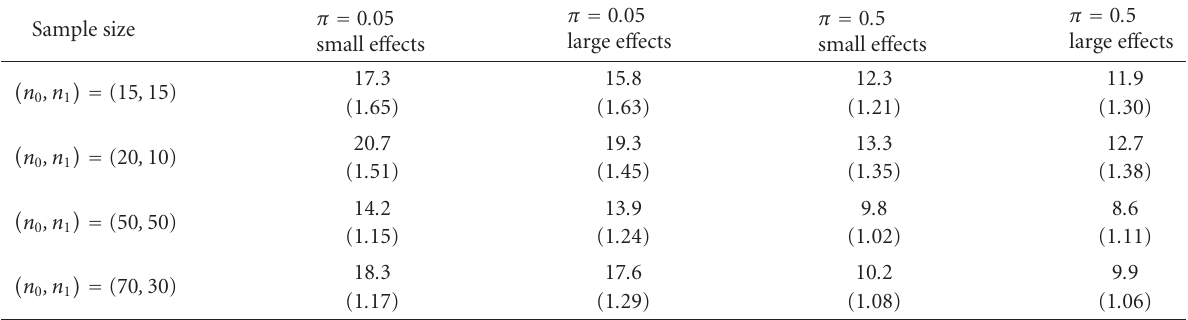
Table 1. Classification error rates (x 100) from simulation study. Numbers in parentheses represent standard errors associated with misclassification rates. Sample